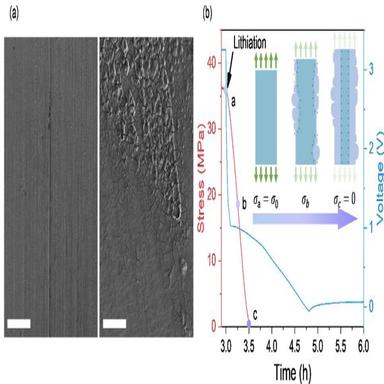
(a) SEM images of Al foil before and after lithiation at a constant current of 0.01 mA for 1 hour, scale bar: 100 μm. (b) ECM stress relaxation of Al electrode during lithiation, under a constant current of 1 mA, corresponding to ∼0.4 C. Once lithiation starts, the stress applied vanished in ∼30 min.